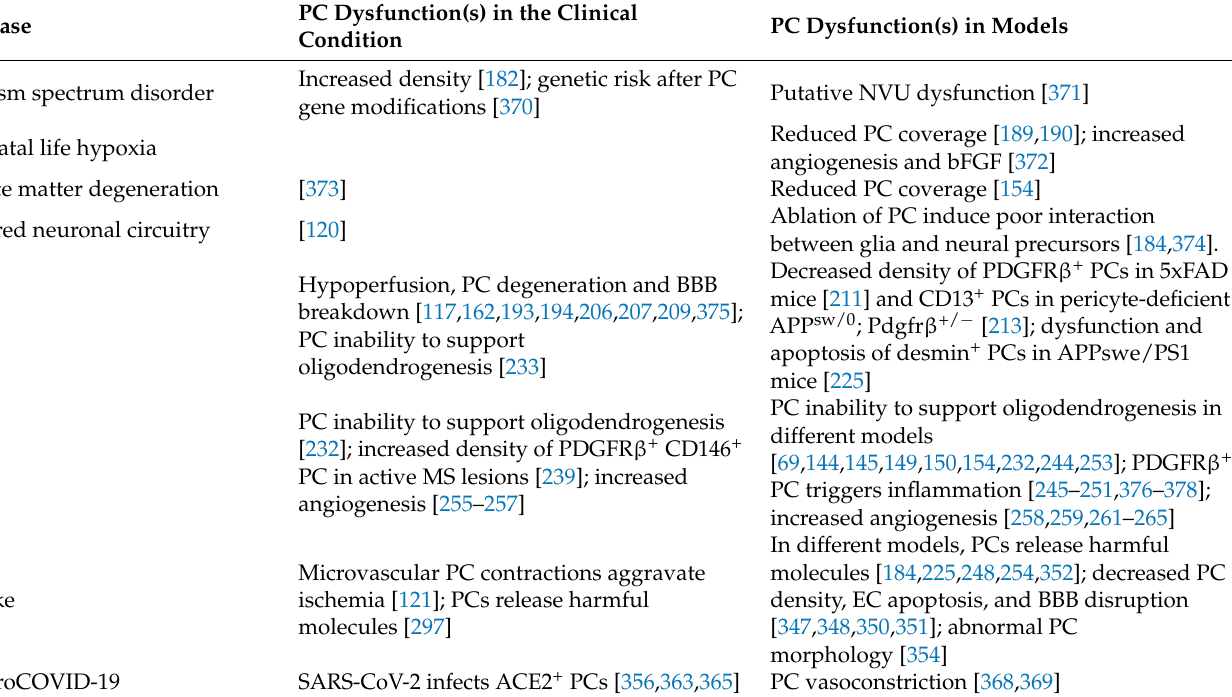
Table 2. Summary of PC dysfunction during clinical and experimental CNS